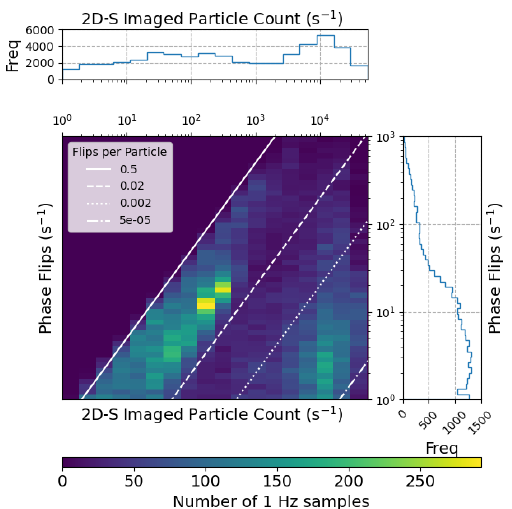
Figure 11. A 2D histogram of 1Hz particle phase flips ( y axis) and 1Hz total particles (including both successfully classified particles and unclassifiable particles) is shown in the large plot. A 1D his- togram of 1Hz total particles is shown on top, on a shared x axis, and a 1D histogram of 1Hz phase flips per second is shown on the right, on a shared y axis. A value closer to the upper left of the plot indicates a higher degree of particle heterogeneity. White lines in- dicate lines of constant heterogeneity for varying particle counts. SOCRATES flights RF01–RF14 are